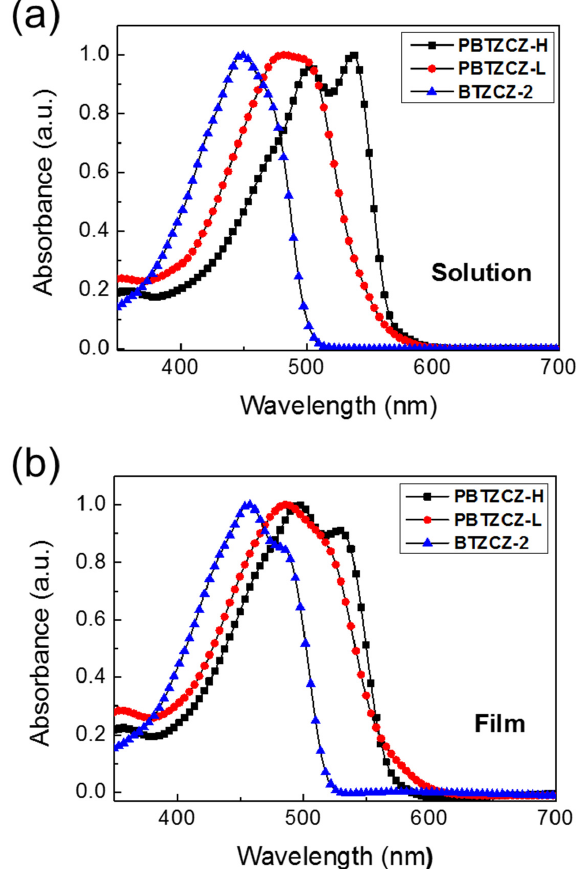
Figure 2. UV/vis absorption spectra of BTZCZ-2 , PBTZCZ-L , and PBTZCZ-H ( a ) in chlorobenzene solution and ( b ) as thin solid films.